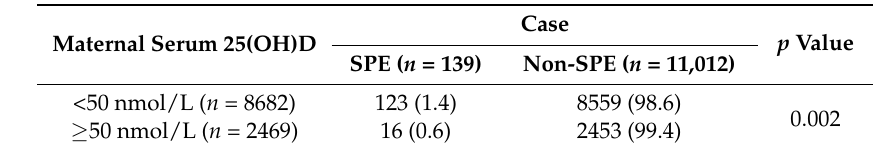
Table 4. Incidence of severe preeclampsia according to maternal serum 25(OH)D concentration at 23–28 weeks of gestation.